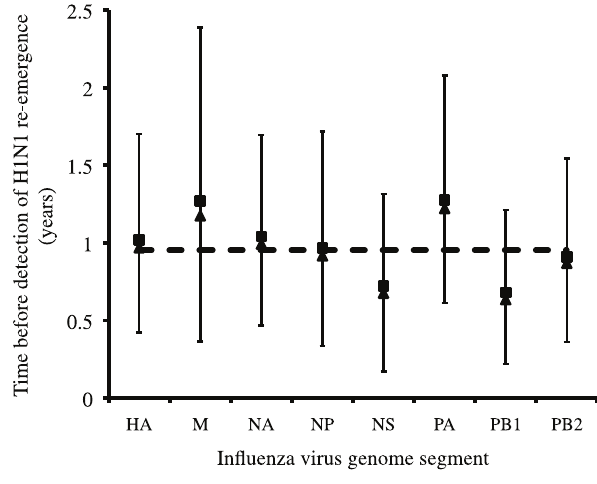
Figure 3. Posterior distributions for the tMRCA of the re- emergent H1N1 lineage for all eight influenza virus segments. Squares are mean values, triangles are median values, bars are 95% highest probability densities, and the dashed line is the sample size weighted average.